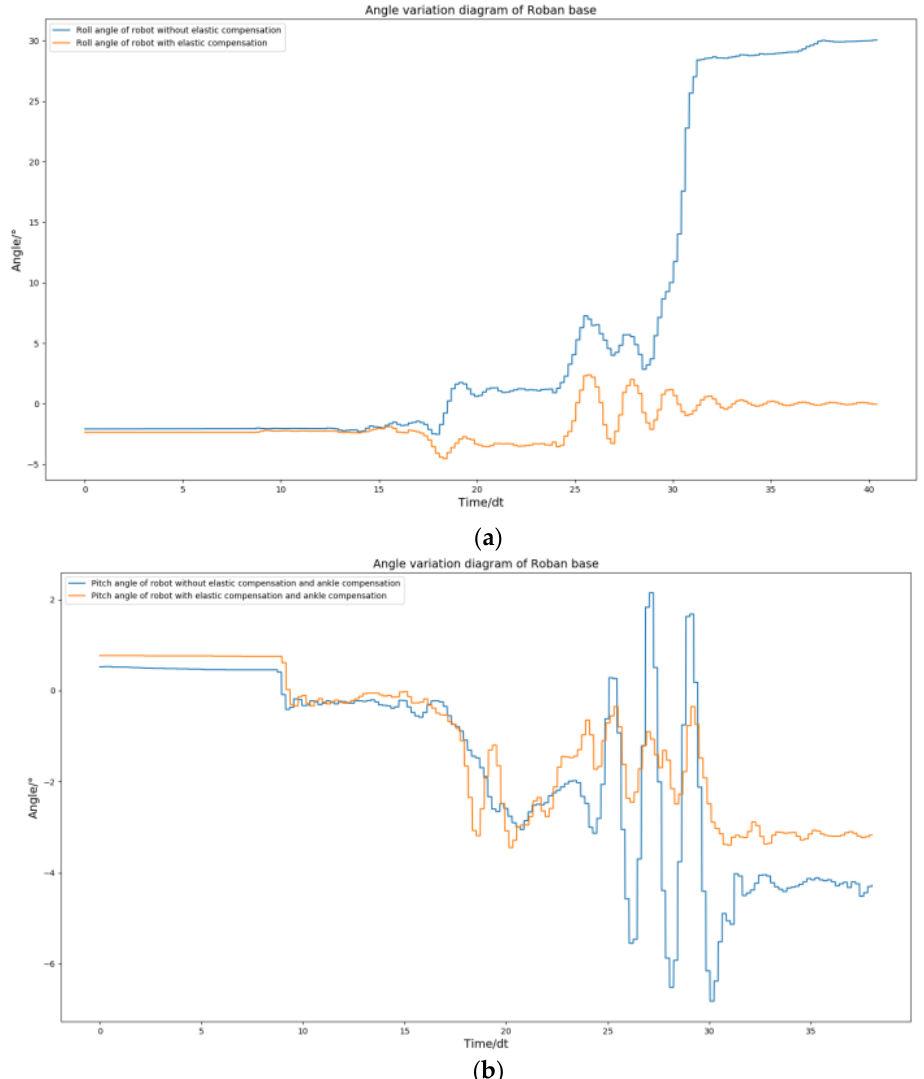
Figure 24. The robot performs a deeper squat. The comparison chart shows the roll angle and pitch angle with and without spring compensation. ( a ) Comparison diagram of roll angle change of robot with and without spring compensa-tion. ( b ) Comparison diagram of roll angle change of robot with and without spring compensa-tion.